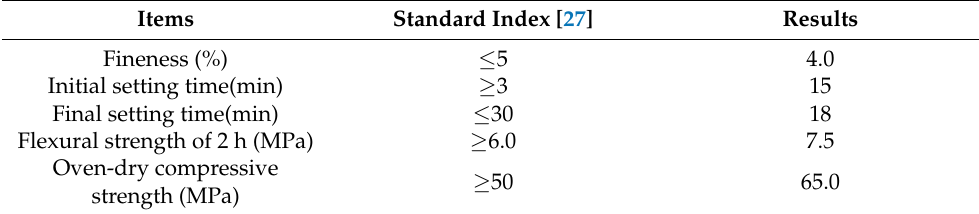
Table 2. Physical performances of the α -hemihydrate gypsum ( α -HH) plaster. Items Standard Index [27] Fineness